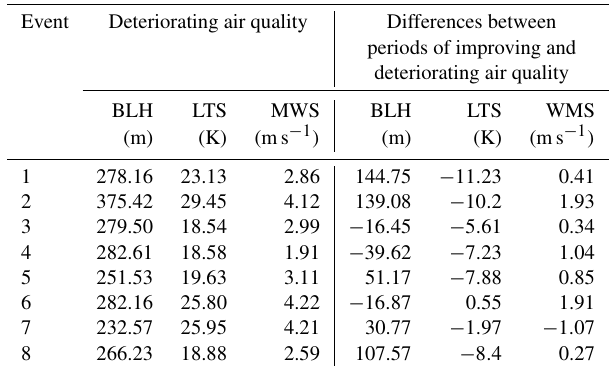
Table 3. Height of the atmospheric boundary layer (BLH), lower tropospheric stability (LTS), and mean wind speed (MWS) in the lower troposphere during periods of deteriorating air quality in each of the eight heavy air pollution events, and the differences of them between periods of improving and deteriorating air quality in each